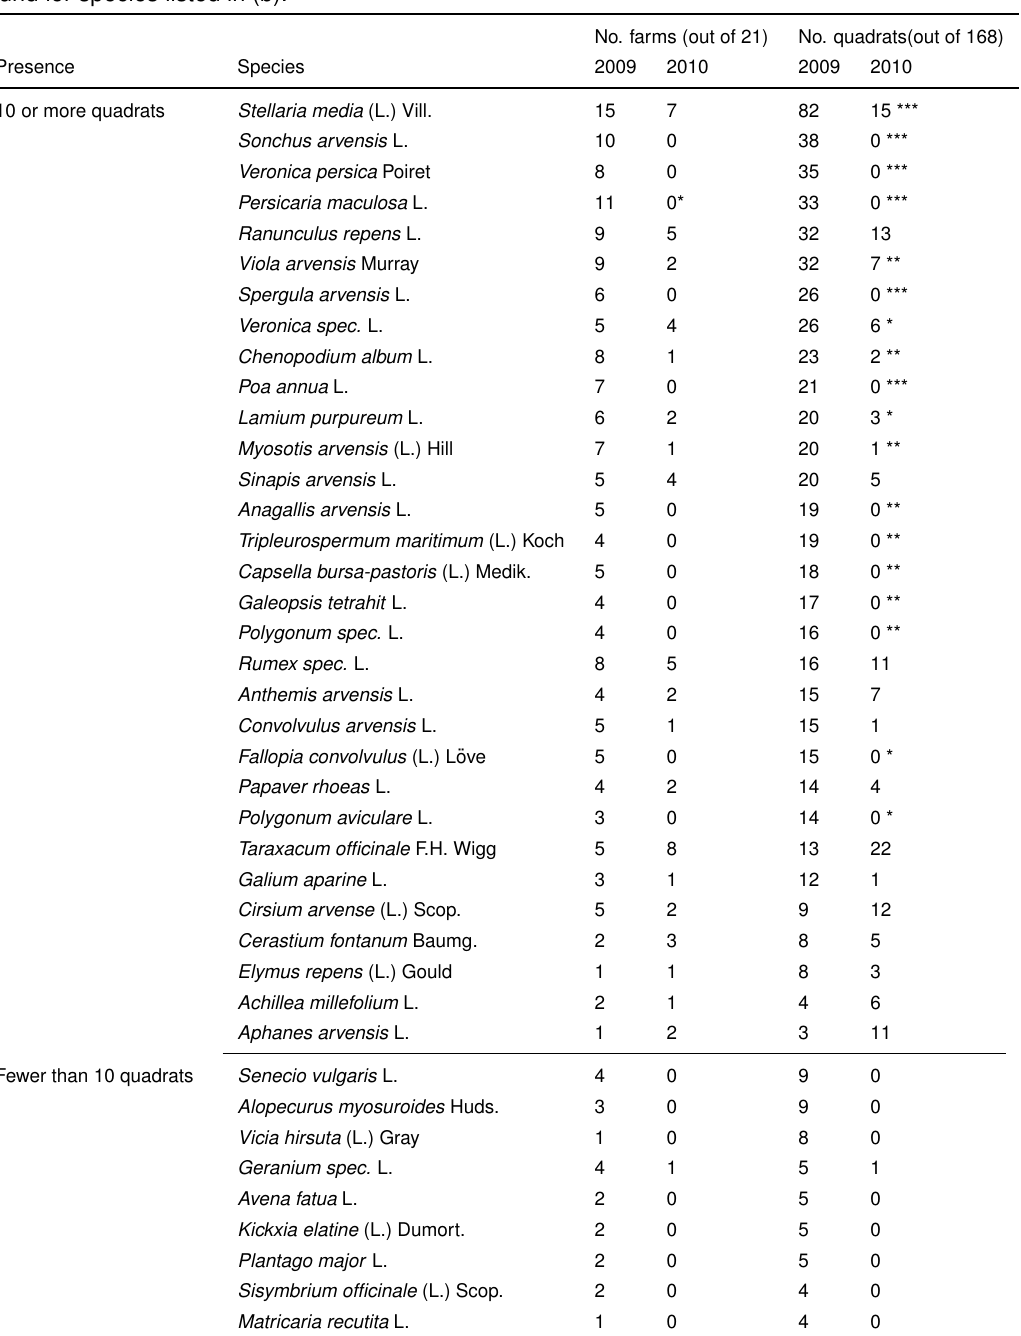
Table 5. Weed species found in year 1 and 2 of the ley on 21 organic farms: Number of farms and number of quadrats in which the weed species were present, sorted in descending order by the number of quadrats in 2009 on which the species was present; (a) species with presence on a total 10 or more sampling quadrats; (b) species with presence on a total of fewer than 10 quadrats. For individual species, the change from the first to the second study year in the number of farms or quadrats on which the species was present was tested for significance with χ 2 tests protected with a Bonferroni correction for multiple testing (***: P < 0.001; **: P < 0.01; *: P < 0.05). No significant effect of sampling year was found for species listed in